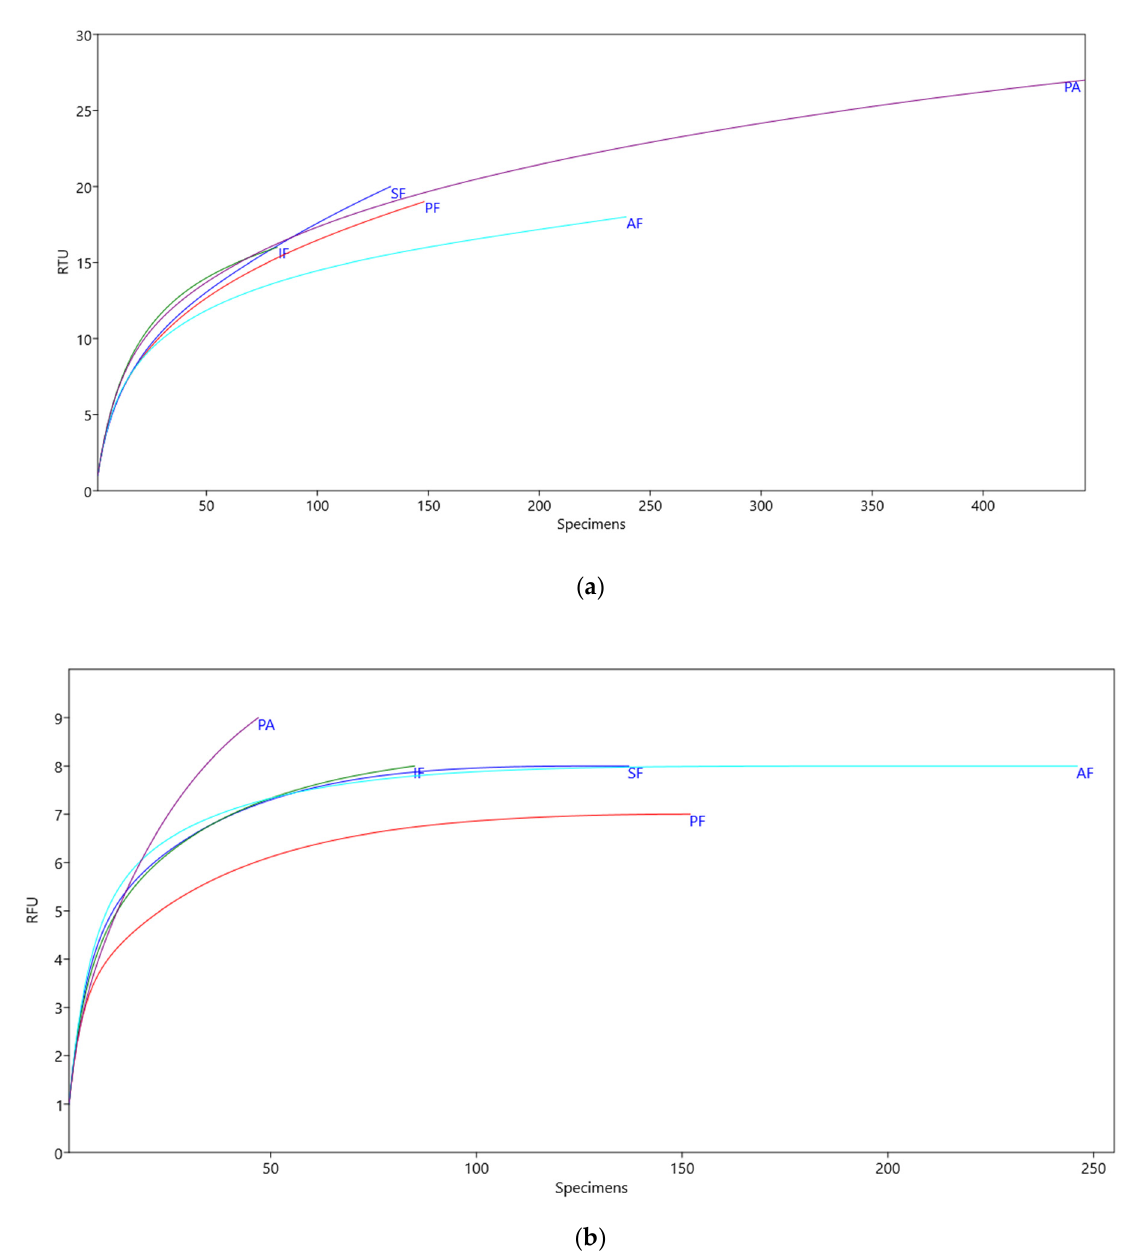
Figure 2. Individual-based rarefaction curves for the studied ecosystems: ( a ) high-level recognizable taxonomic units (RTU). ( b ) High-level recognizable functional units (RFU). Primary Forest (PF), Secondary Forest (SF), Incipient Forest (IF), Agroforestry (AF) and Pasture (PA).